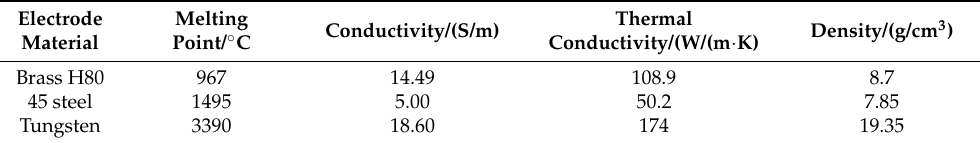
Table 2. Physical parameters of electrodes of different materials.